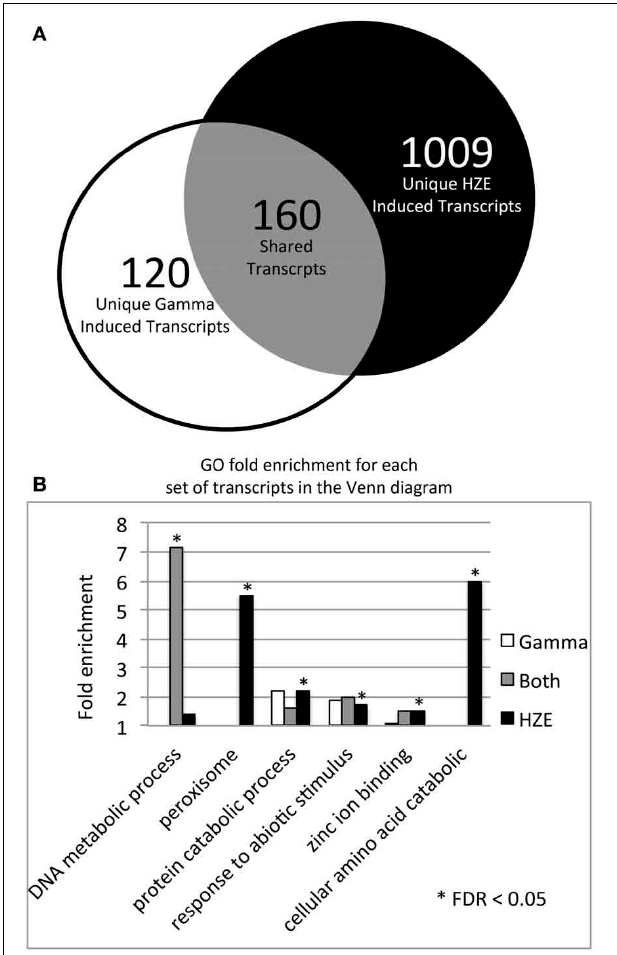
FIGURE 3 | HZE and gamma induce DNA metabolic transcripts 1.5h after IR. (A) The Venn diagram shows the overlap of the 280 gamma radiation and 1169 HZE-induced transcripts at 1.5h after irradiation (fold change > 2 and adjusted p -value < 0.05). We used the 1.5h unirradiated control for the 1.5–12h time points and the 24h unirradiated control for the 24h time point. (B) The bar graph shows the fold enrichment of the gamma radiation unique, HZE unique, and shared induced transcript sets shown in the Venn diagram in (A) for each GO category that is significantly overrepresented in at least one of these transcript